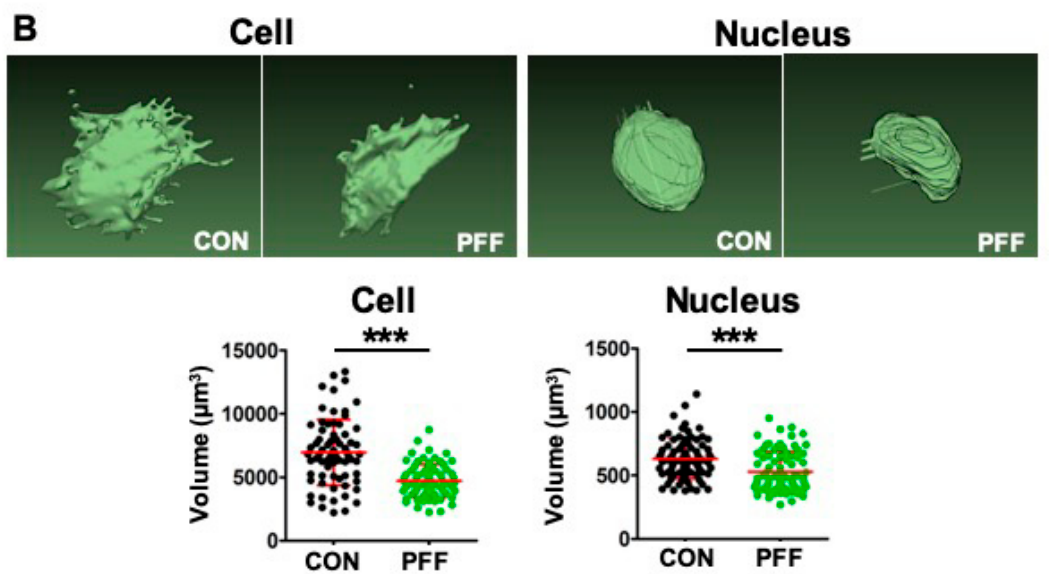
Figure 1. E ff ect of 1 h pulsating fluid flow (PFF) on live and fixed cell and nucleus volumes of MC3T3-E1 osteoblasts. ( A ) Volumetric reconstruction and cell volume of live cells exposed to PFF at di ff erent time points. n = 24 cells from six glass slides. ( B ) Volumetric reconstruction and volume of cells and nuclei in formaldehyde-fixed cells subjected to 1 h static control culture or PFF treatment. n = 70 cells from 9 glass slides. CON, control; PFF, pulsating fluid flow. Significant e ff ect of PFF, ** p < 0.01 and *** p < 0.001.